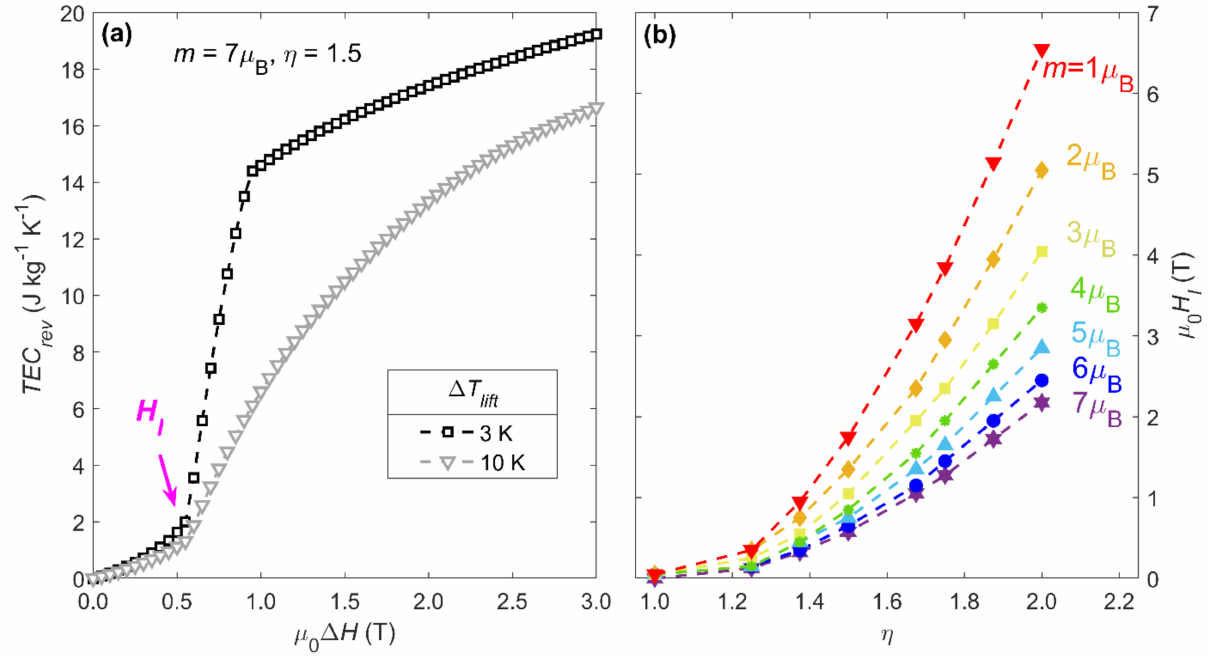
Figure 3. ( a ) Magnetic field dependence of the reversible TEC for η = 1.5 and m = 7 µ B using a ∆ T lift of 3 and 10 K; ( b ) H I as a function of η for different atomic magnetic